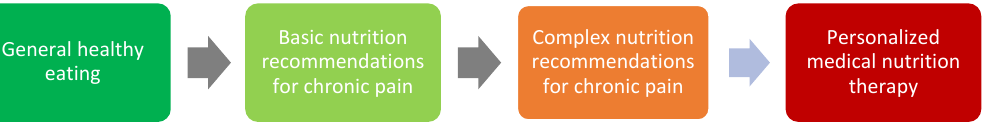
Figure 3. Nutrition and the chronic pain scope of practice.